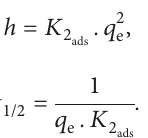
Figure 12: Variation in the adsorbed amount of (a) IC and (b) 2,6-DCPIP at equilibrium on CTAB-modified POF and (c) evolution of R values against the initial dye